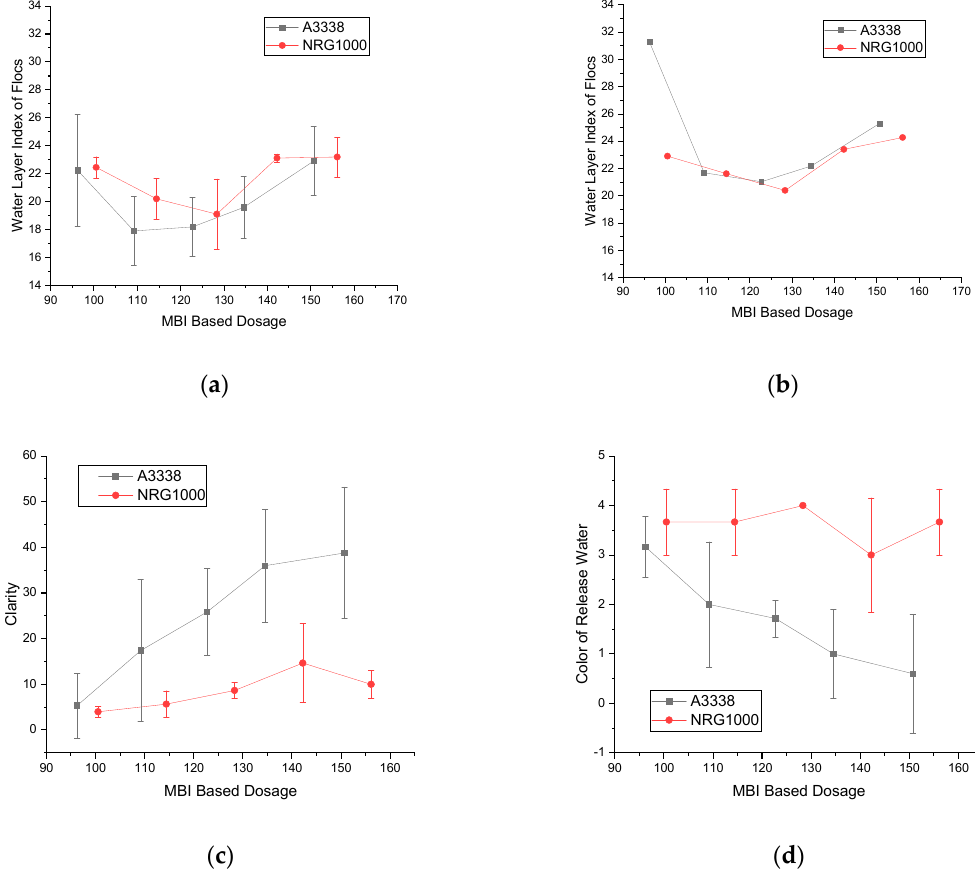
Figure 14. The comparison of two polymers A3338 and NRG1000 in case of FFT-1 dewatering: ( a ) the average dewatering results with 95% confident index error bars; ( b ) the best dewatering results; ( c ) the average clarity numbers of the release water with 95% confident index error bars; ( d ) the average color scales of the release water with 95% confident index error bars.